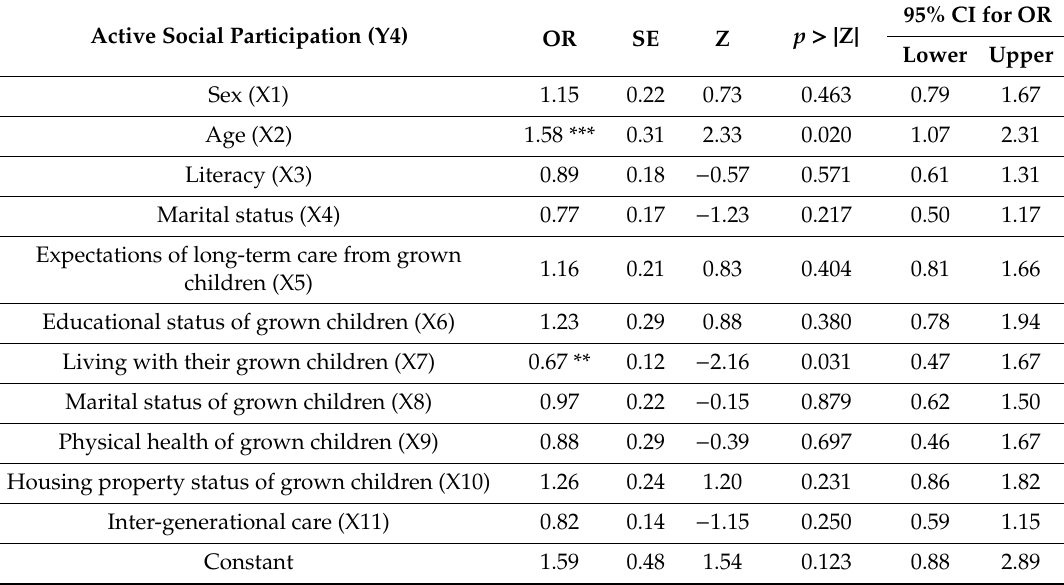
Table 8. Logistic regression results of active social